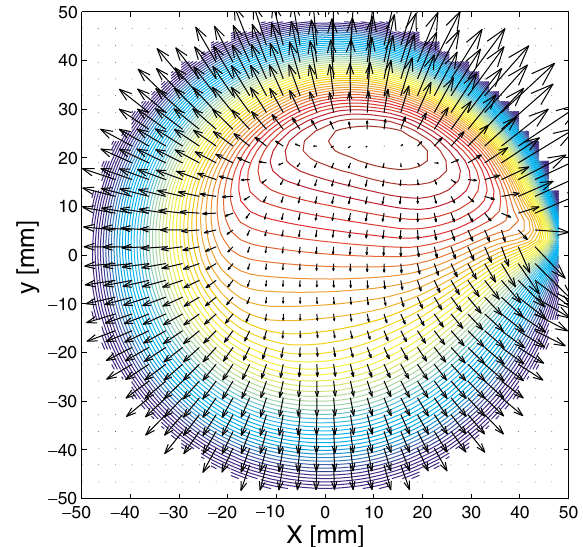
FIG. 4. (Color) Potential and field interpolation of the PIC method. The color shows the potential; the arrows denote the field direction and contour according to Eq. (10). Note that the distribution of the photoelectrons is three dimensional.